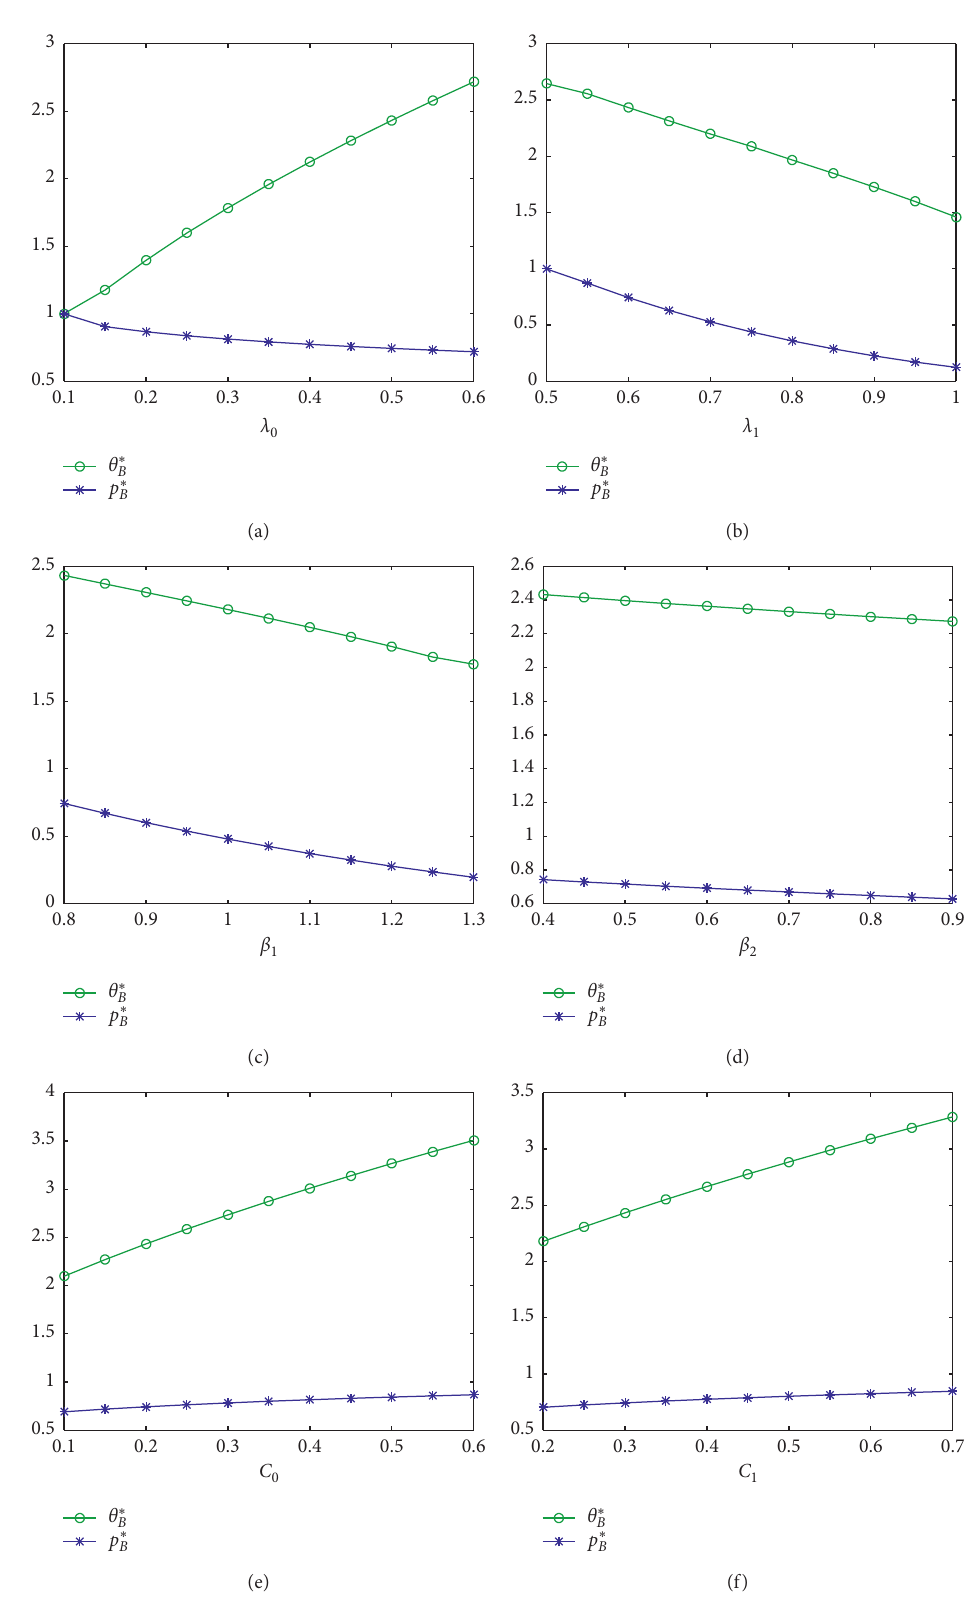
, p ∗ , and U ∗ on λ B B � 0 . 2 ,C � 0 . 3 , λ 0 1 � 0 . 6 , and β � 0 . 8; (e) C 1 1